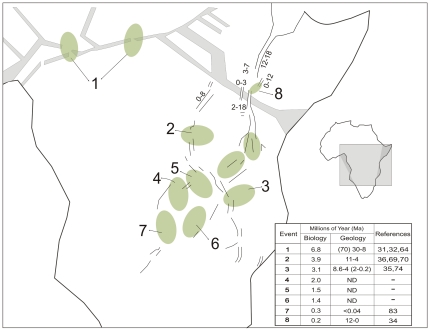
The spatio-temporal congruence of cladogenic events in Hydrocynus with episodes of tectonism in the African Rift System.Schematic diagram of south-central Africa illustrating geobiotic regions that delimit the likely locations where antecedent drainage links were tectonically disrupted during rifting and uplift (numbered green ellipses). These events altered boundaries between major drainage basins. Cladogenic events in tigerfishes, constrained by molecular dating of mtDNA sequences, provide biochronologic markers as proxy indicators of these geotectonic events for a subset of rifts (black lines). The inset compares our derived biochronology against the most reliable geochronology derived from the geological literature (numbers denote referenced sources) pertinent to these geobiotic regions. Note that in the Late Cretaceous (66–120 Ma), the Central African Rift System stretched across central Africa from the Atlantic to the Indian Oceans during the initial opening phases of these two oceans (pale gray), but today is only active in west-central Africa, along the Cameroon Line [105], [106]. In East Africa, this early rift phase (Anza Rift) terminated before the onset of the transecting and active East African Rift System (EARS). Here refined geological dates constrain tectonism between 4–12 Ma (focused at ca. 5.5 Ma; see table of cited authorities on Figure), propagating southwards from the Afar Plateau [107]. The new biochronology, derived from Hydrocynus evolution, also supports a young and active incipient phase of southwest rift-propagation across the Kalahari Plateau, as has been inferred by geologists for more than 70 years but without firm geochronological evidence. A lacustrine radiation of Synodontis catfishes constitutes biochronological evidence for Early Pleistocene initiation of tectonism 1.4>0.9<0.4 Ma [12], [71] in the Okavango graben (Event 7). See text for additional discussion and references.